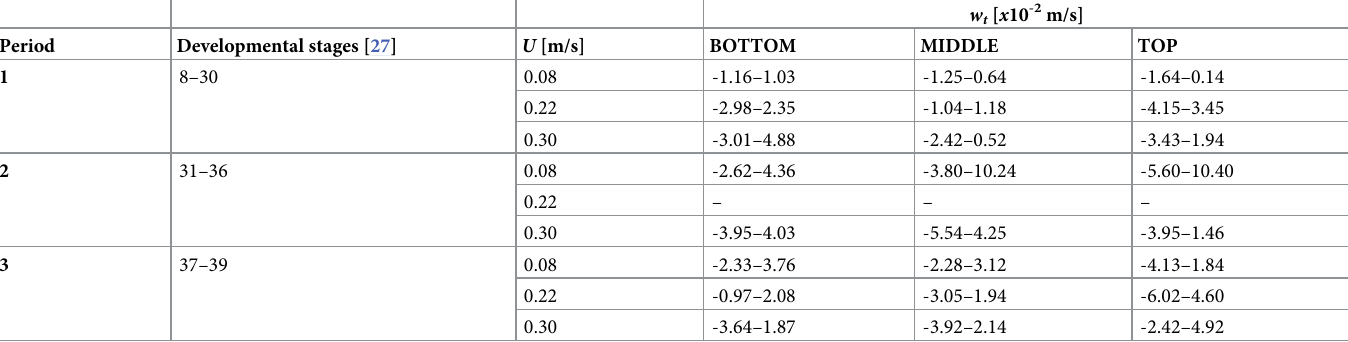
Table 2. Estimated minimum and maximum vertical traveling speeds, w t , at each of the water profile regions defined. Bottom (0 to 0.15 m above the bed), middle (0.15 to 0.30 m), and top (0.30 to 0.40